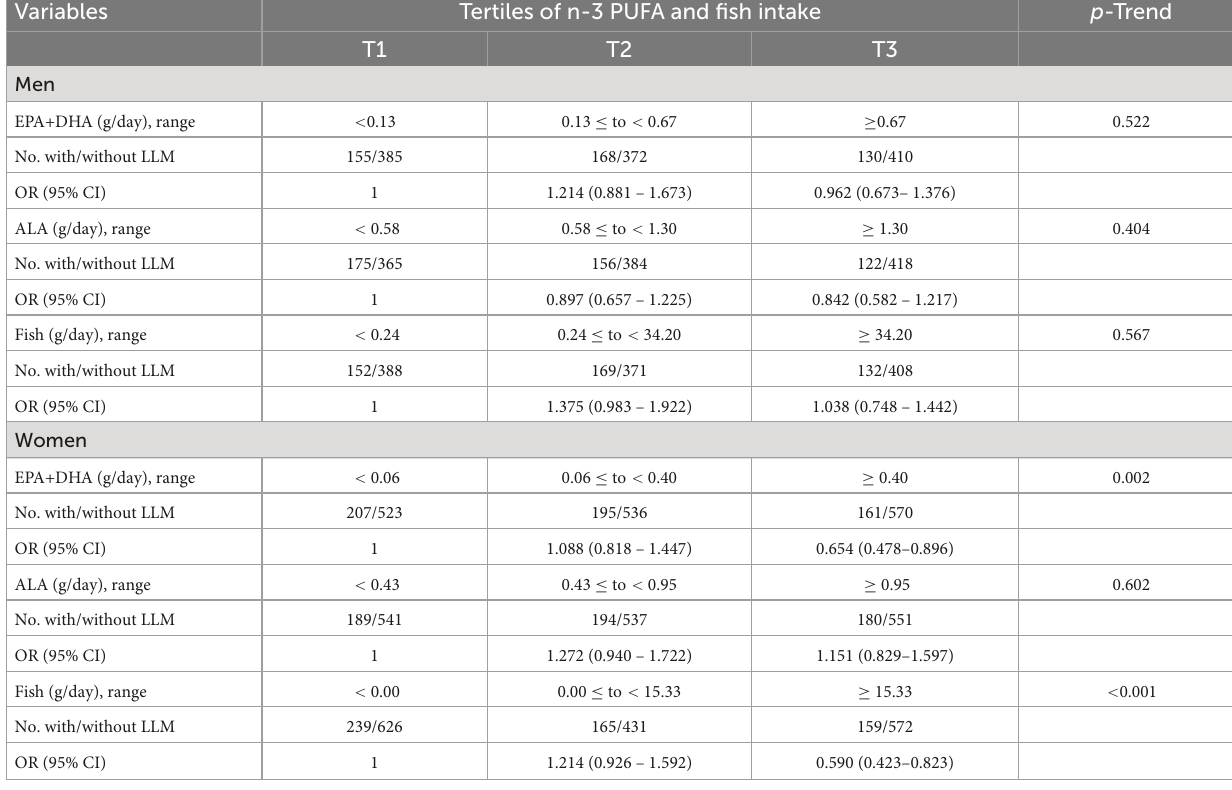
TABLE 2 Associations between prevalence of low lean mass and n-3 PUFA and fish intake in men and women. Variables Tertiles of n-3 PUFA and fish intake p